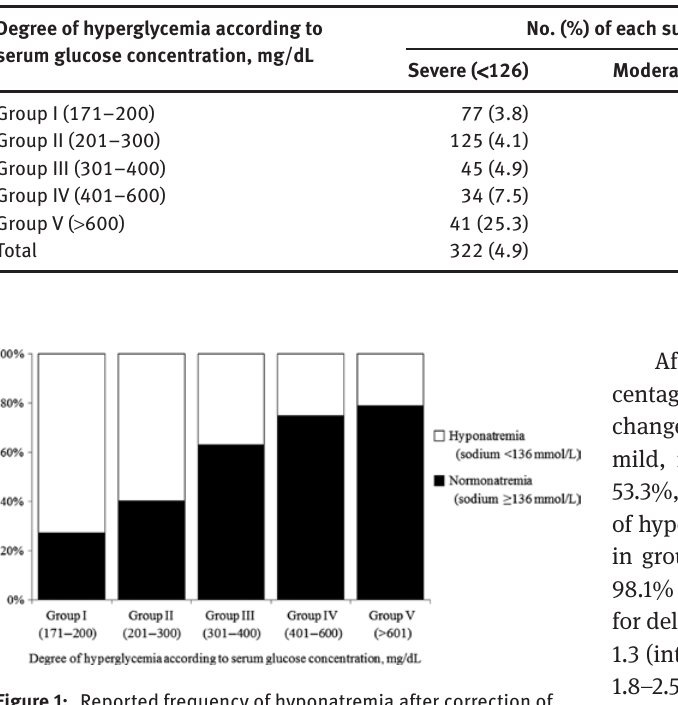
Figure 1: Reported frequency of hyponatremia after correction of sodium concentrations.